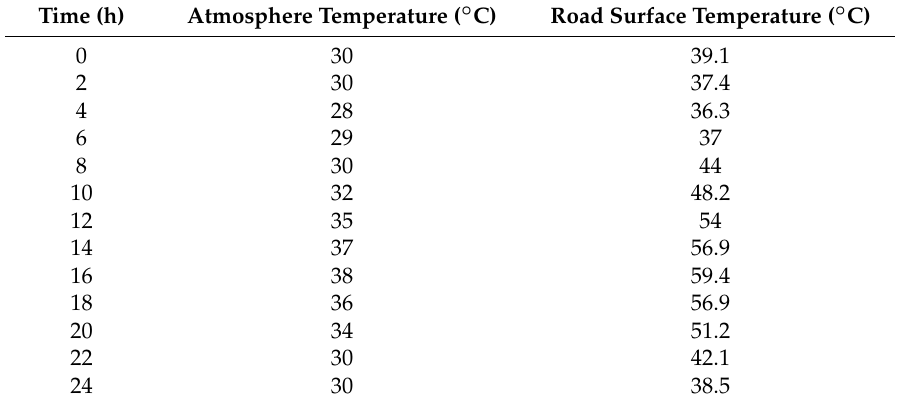
Table 5. Measured temperatures of atmosphere and road surface ( ◦ C).